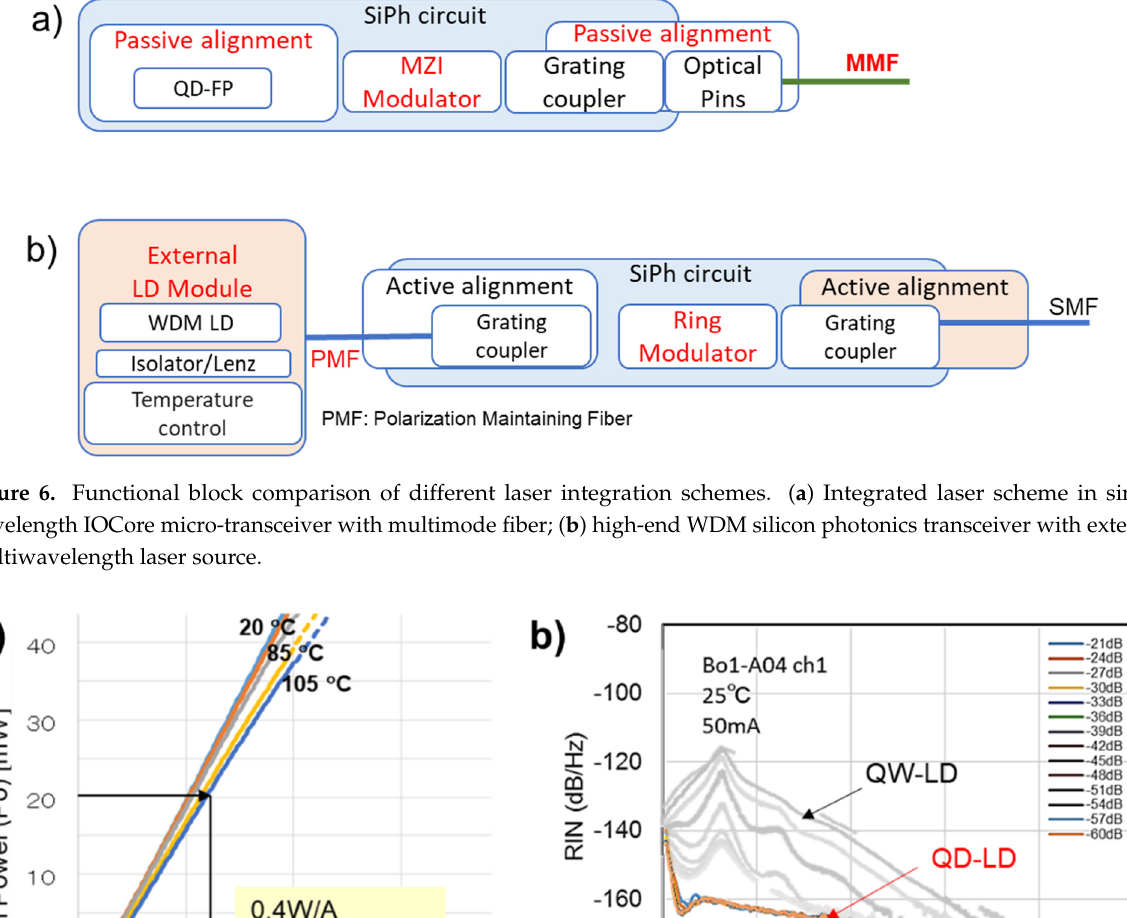
Figure 6. Functional block comparison of different laser integration schemes. ( a ) Integrated laser scheme in single wave- length IOCore micro-transceiver with multimode fiber; ( b ) high-end WDM silicon photonics transceiver with external multiwavelength laser source .